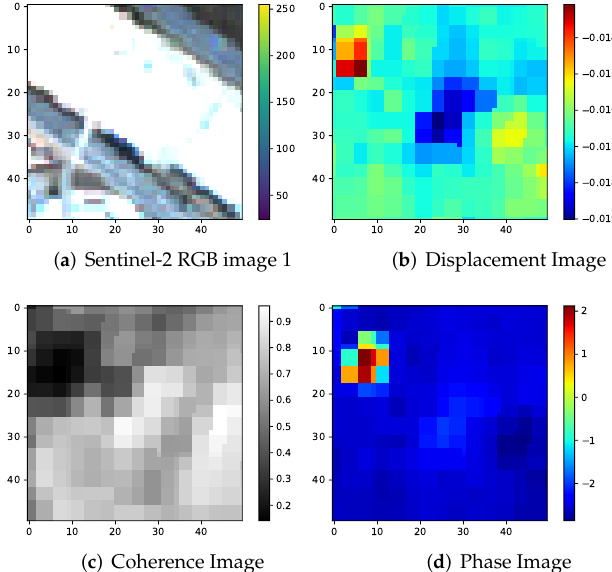
Figure 17. True-positive blob of a factory yard in